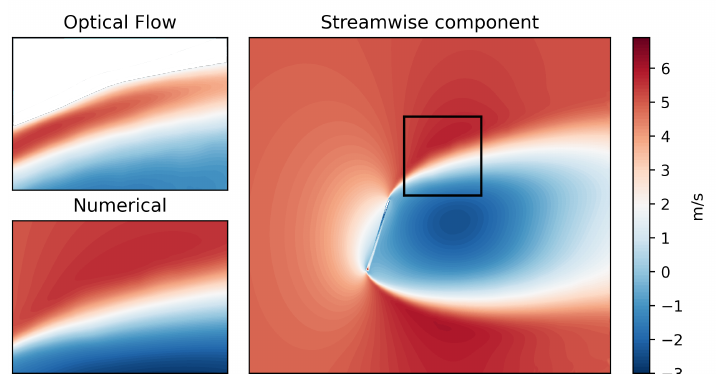
Figure 16. Percentage error for the numerical model in the estimation of the pressure for the front = 7.11%) and rear ( ERR ave = 7.13%) side. The numbering of the points indicated on the ( ERR ave F R panel plane is the same as in Figures 13 and 14.